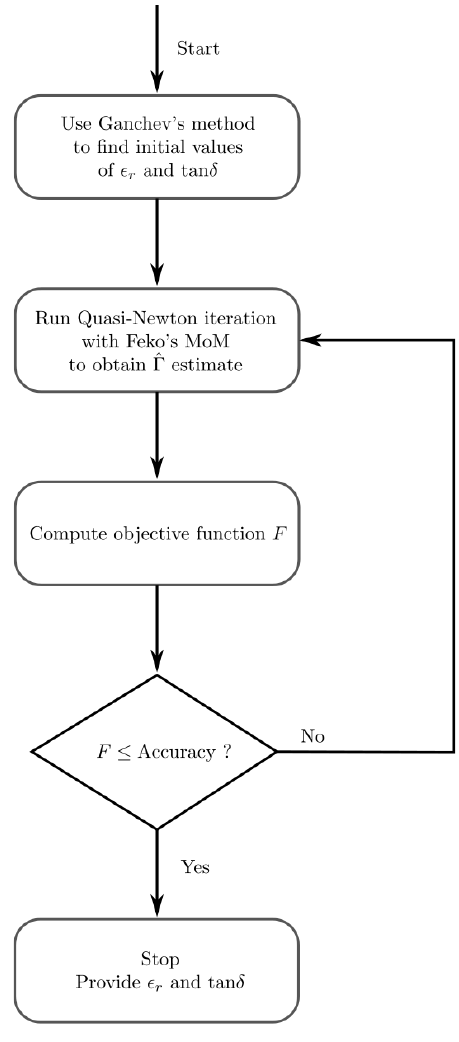
Figure 4. Flowchart for obtaining (cid:101) r and tan δ .